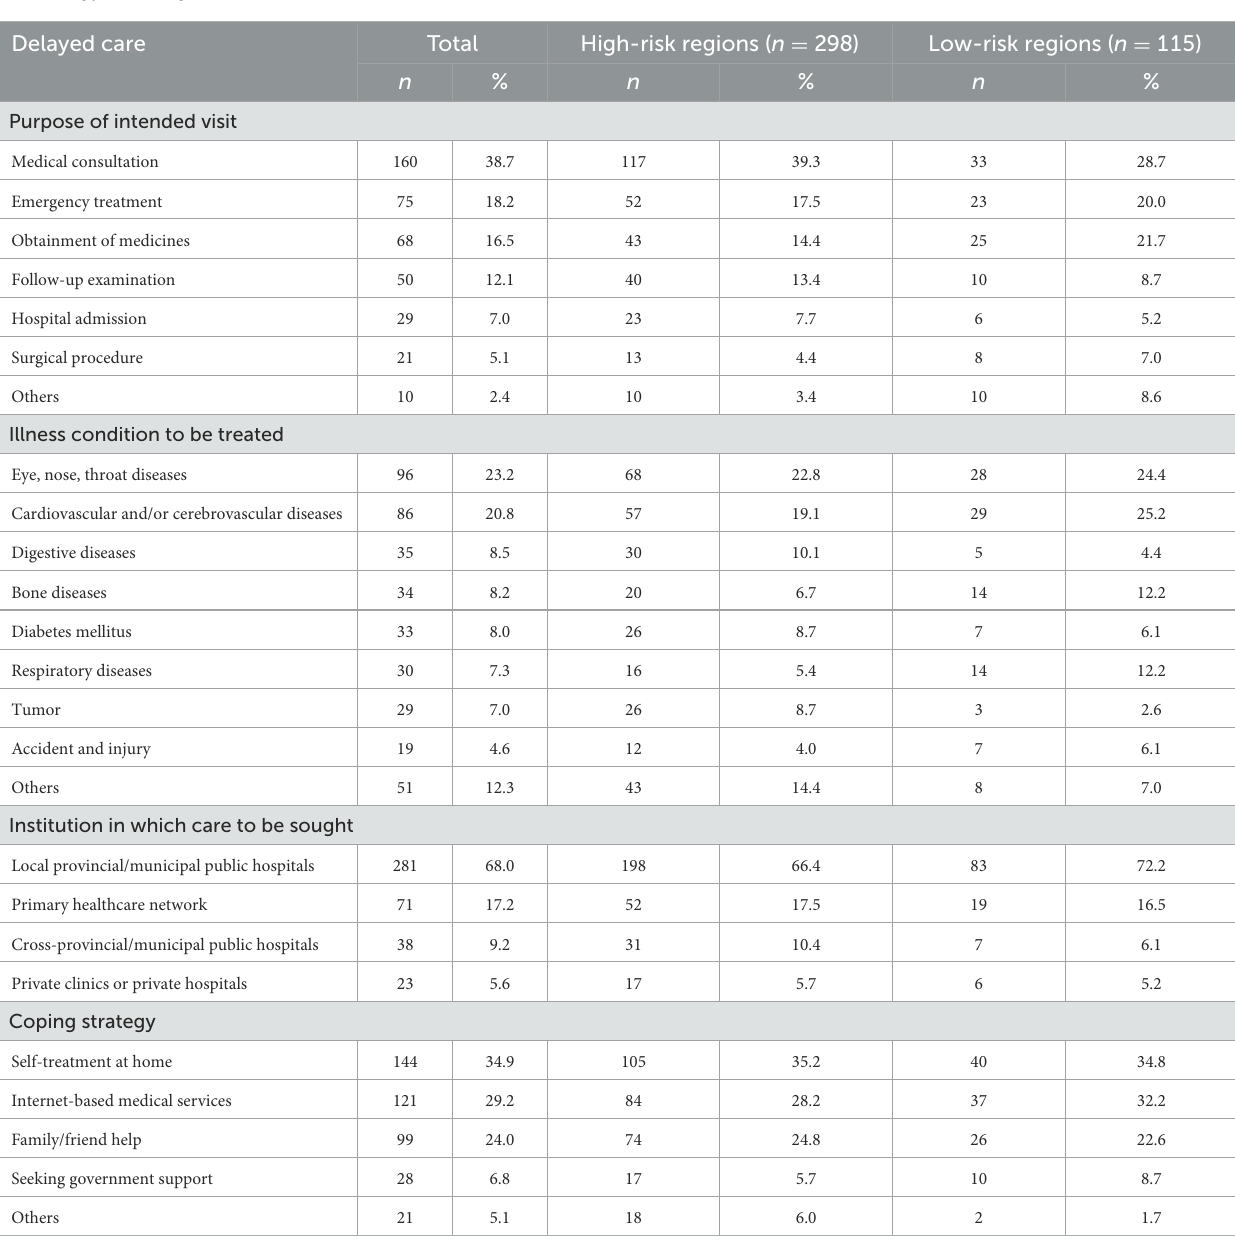
TABLE 3 Types of delayed care ( n =